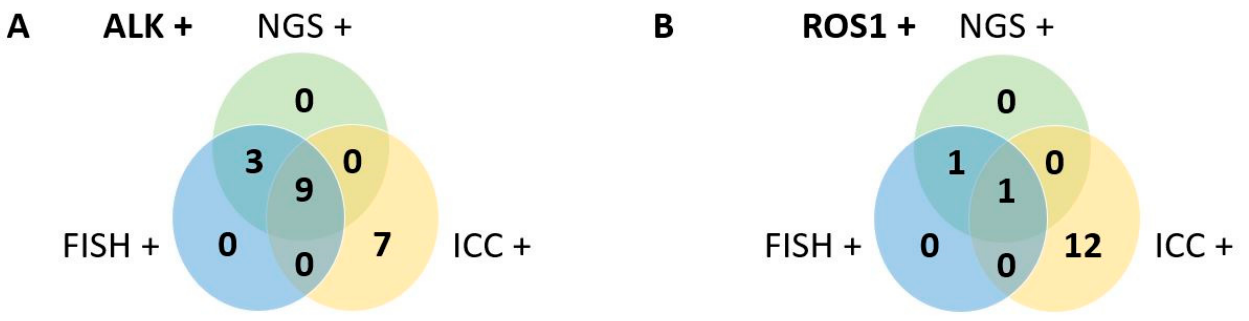
Figure 2. A Venn diagram of ALK-positive ( A ) and ROS1-positive ( B ) cases detected by NGS, ICC and FISH in cytological samples. Four patients and one patient were excluded for ALK or ROS1 results, respectively, because of non-interpretable results in one of the methods. Table 2. Sensitivity and specificity of ICC and FISH compared with NGS. FN, false-negative; FP, false-positive; TN, true-negative; TP, true-positive; Se: sensitivity; Spe: specificity. Technique ALK